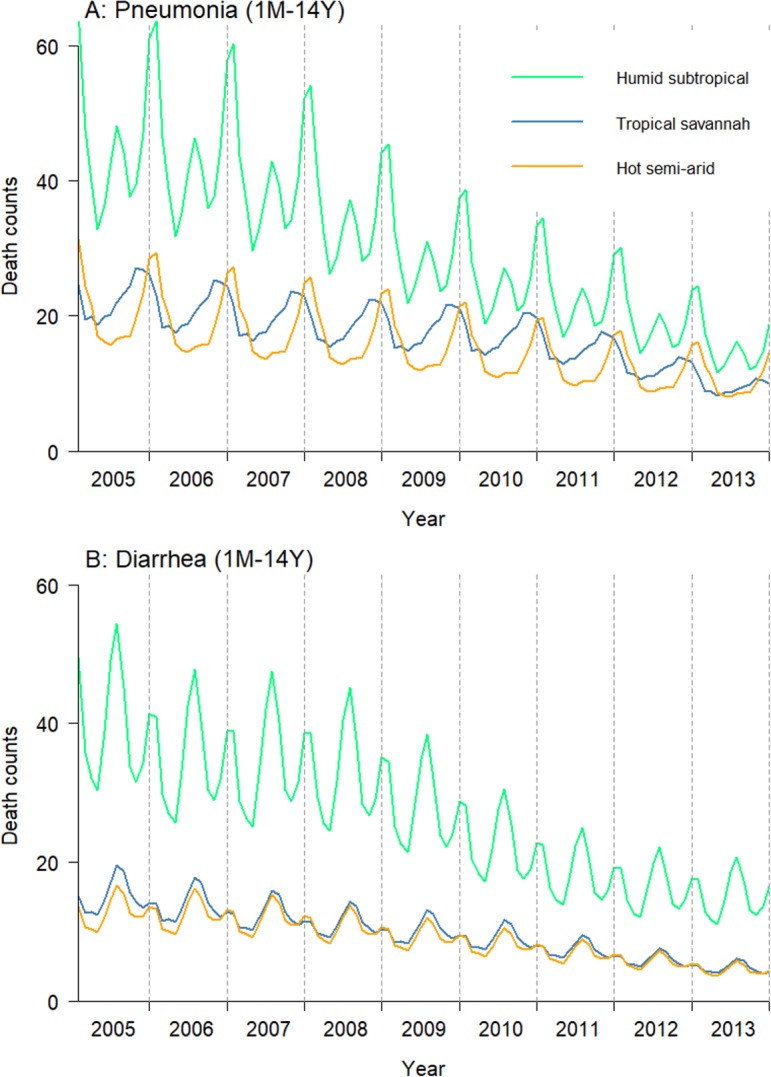
Time series model for (A) pneumonia and (B) diarrhea by Köppen-Geiger climate region.Diarrhea cases shown here are only those that did not exhibit fever and bloody stool. Data was modeled using a generalized additive model and Poisson regression, using monthly count of deaths from the Million Death Study. Each checked horizontal line designates December of each year. Given three regions also had a smaller sample size on which to model, they were bundled into regions with similar climatic characteristics (tropical monsoon into tropical savannah, hot desert into hot semi-arid, and subtropical highland into humid subtropical). Each dashed vertical line designates December of each year.10.7554/eLife.46202.020Figure 6—figure supplement 1—source data 1.Predicted values for pneumonia and diarrhea mortality time series models by climate region; 2005–2013.